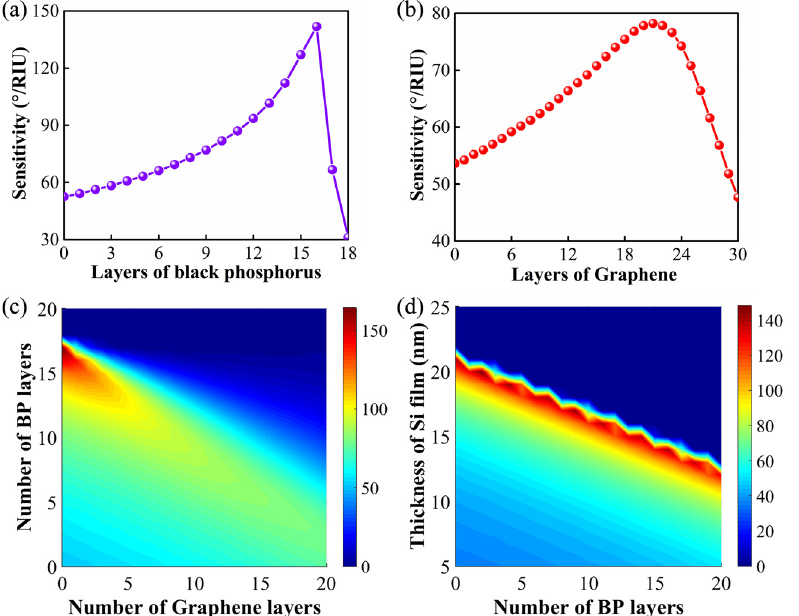
Figure 5: Sensitivity changes with various structure parameters when the refractive index (RI) of sensing target is 1.33 RIU, and thethicknessofsilicon(Si) fi lmis 14nm.(a) The number of the black phosphorus (BP) layers where the number of the graphene layers is S = 1; (b) number of the graphene layers where the number of the BP layers is L = 1; (c) number of the BP and graphene layers; (d) number of the BP layers and the thicknessofSi fi lmwherethenumberofthe graphene layers is S =